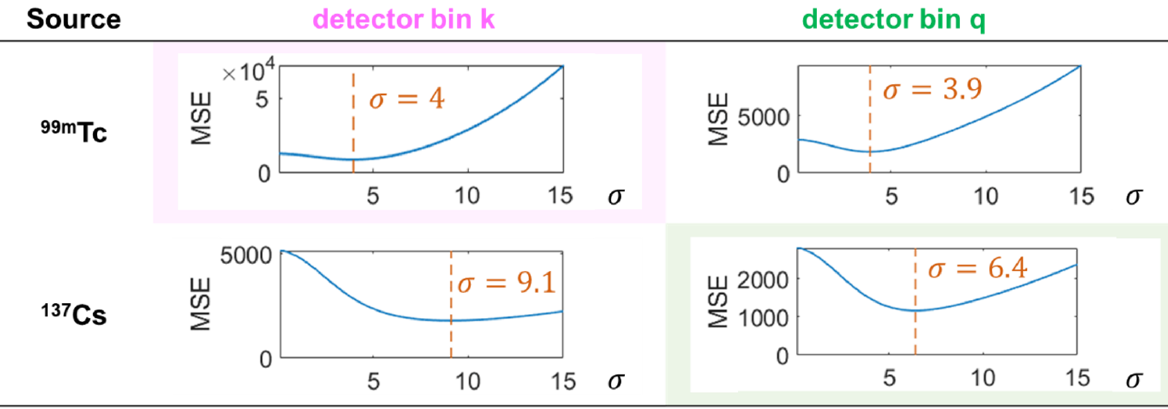
Figure 8. σ -MSE curves of representative detector bins for 99m Tc and 137 Cs sources.